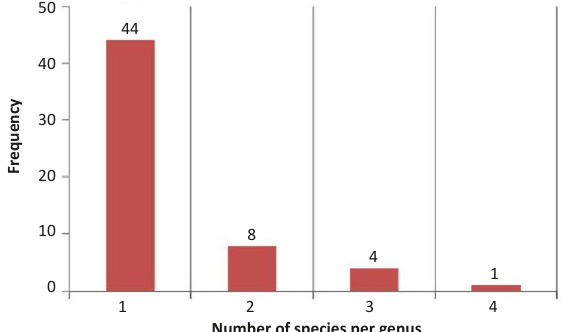
Figure 2. Frequency of the number of butterfly species recorded for each genus reported from Indian Sundarbans. The total number of observation in each category is shown on top of the bar. Most of the genera were represented by single species.